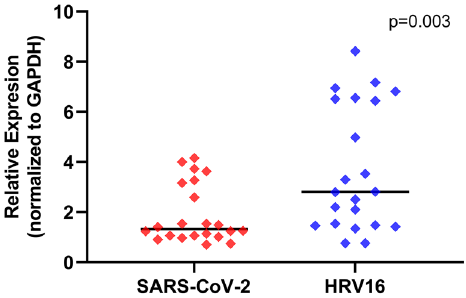
Figure 7. Relative gene expression of pattern-recognition receptor and RNA viral sensor IFIH1 (MDA5) (normalized to GAPDH expression) by primary bronchial airway epithelial cell cultures in children (n = 14) and adults (n = 8). Gene expression was quantified by PCR in RNA harvested 96 h after parallel infection with SARS-CoV-2 WA-01 (MOI = 0.5, red diamonds) or HRV-16 (MOI = 0.5, blue diamonds). IFIH1 expression was significantly higher after HRV-16 infection than after SARS-CoV-2 infection (p = 0.003 by Wilcoxon matched- pairs signed rank test; bars indicate median